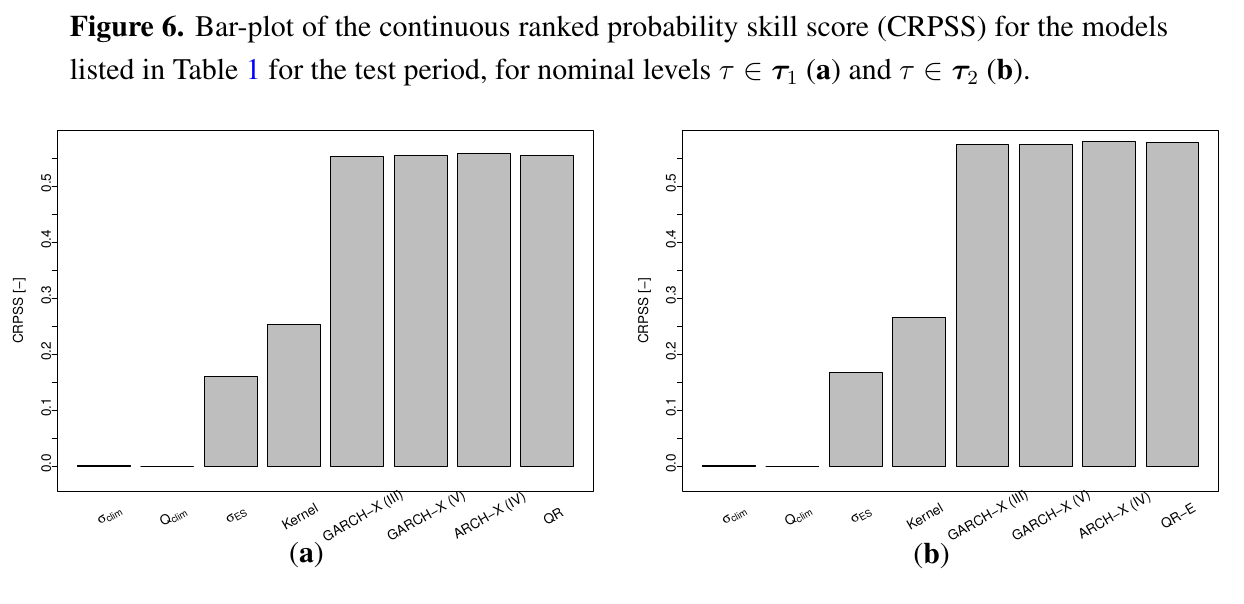
Figure 6. Bar-plot of the continuous ranked probability skill score (CRPSS) for the models listed in Table 1 for the test period, for nominal levels τ ∈ τ